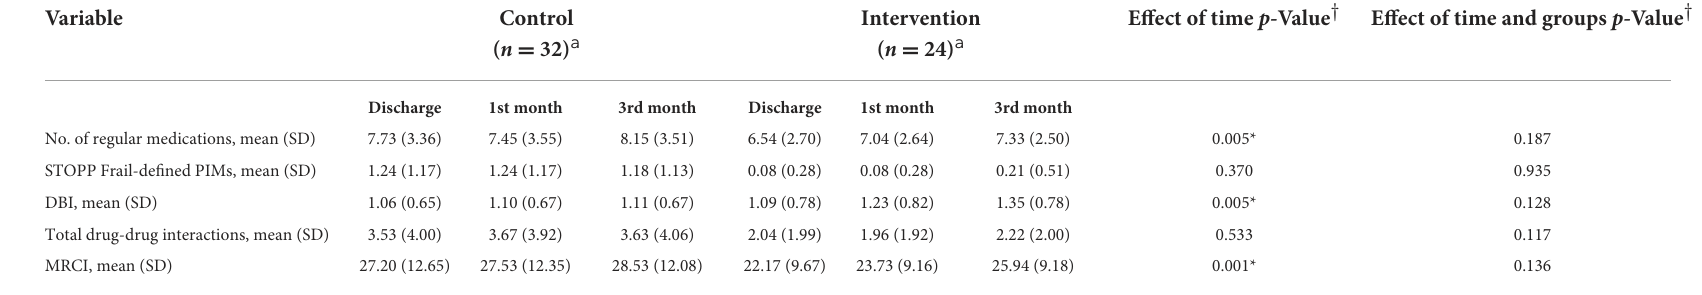
TABLE 3 Effect of time in pharmacotherapeutic variables after the application of the person-centered prescription.